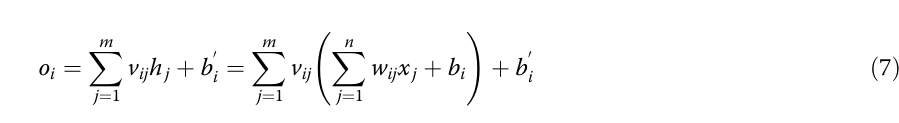
Fig. 2 Structure of level classification